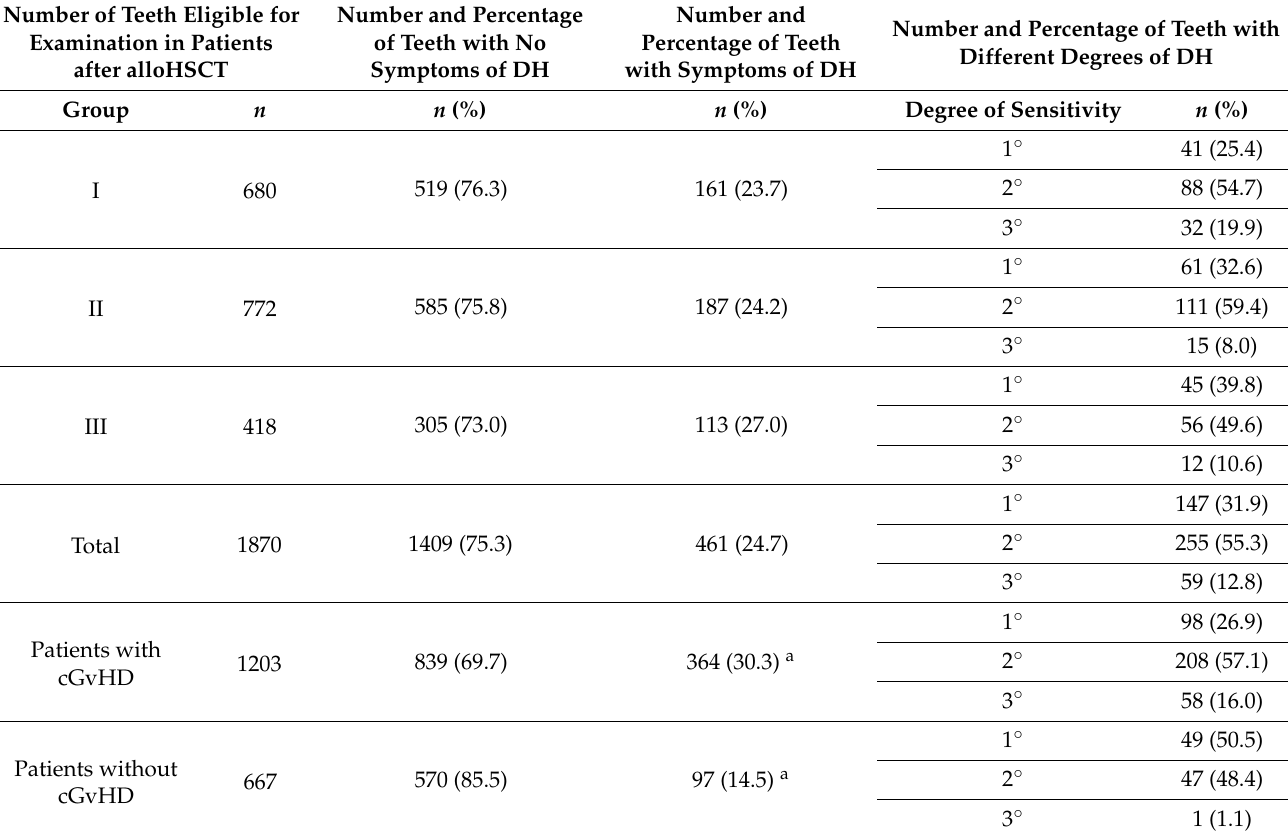
Table 4. Number and percentage of teeth with symptoms of dentin hypersensitivity, taking into account time elapsed since alloHSCT and incidence of